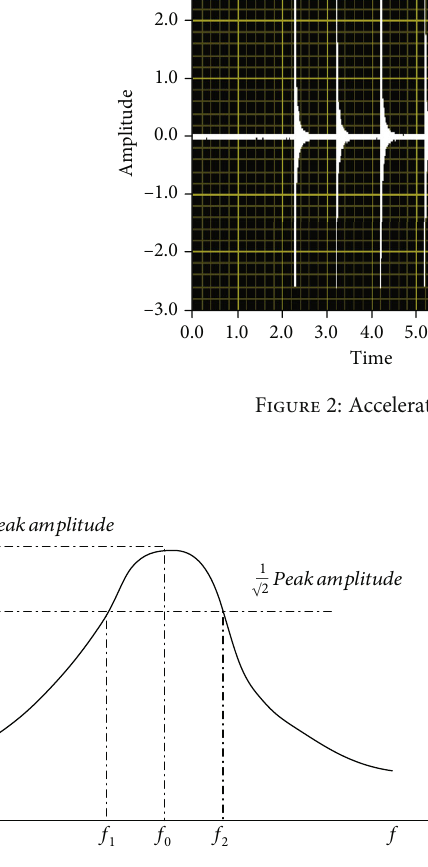
Figure 3: The half-power bandwidth method for the estimation damping ratio of concrete [26].